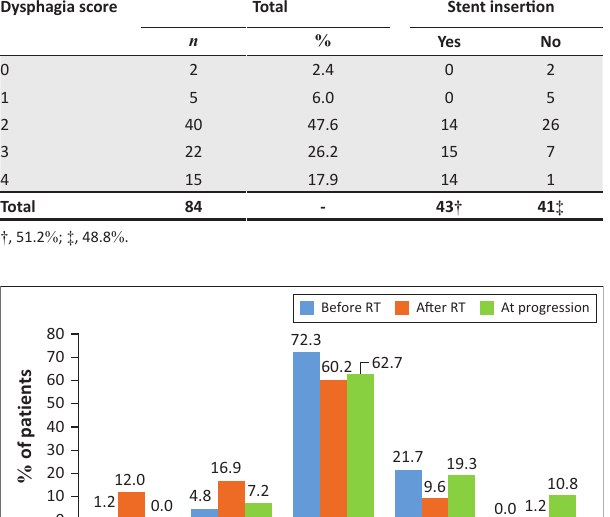
TABLE 2: Dysphagia score at presentation and in patients having stent insertion. Dysphagia score